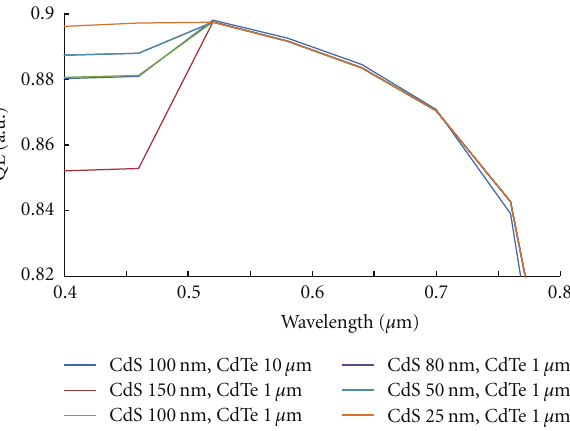
Figure 5: E ff ect of CdS window layer thickness on the spectral response (quantum e ffi